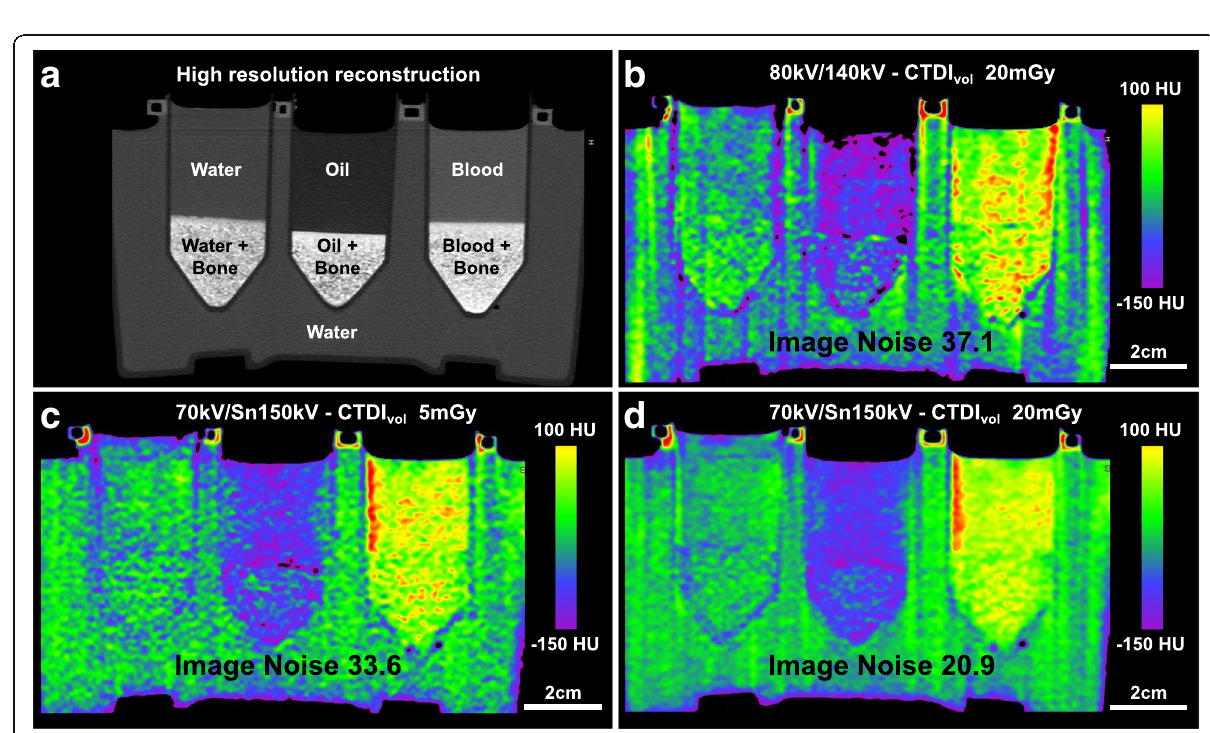
Fig. 3 Higher spectral separation can compensate for the increase in image noise in lower dose virtual non-calcium images. High-resolution conventional reconstruction ( a ) and virtual non-calcium reconstructions ( b − d ) at three different tube-voltage and dose combinations at the same position. Image noise for each reconstruction is stated and is the mean standard deviation for the three chambers with fluid and bone. Notice in b and d a volume computed tomography dose index of 20 mGy, but the higher difference in tube voltage and use of a tin filter leads to a reduction in image noise. While at a constant tube-voltage combination in c and d , the increase in dose leads to a decrease in image noise. Similar image noise is seen at a four times reduced dose between b and c , indicating that scans with lower spectral separation must increase the dose to maintain similar image noise; CTDI vol Volume computed tomography dose index; Sn indicates the use of a tin